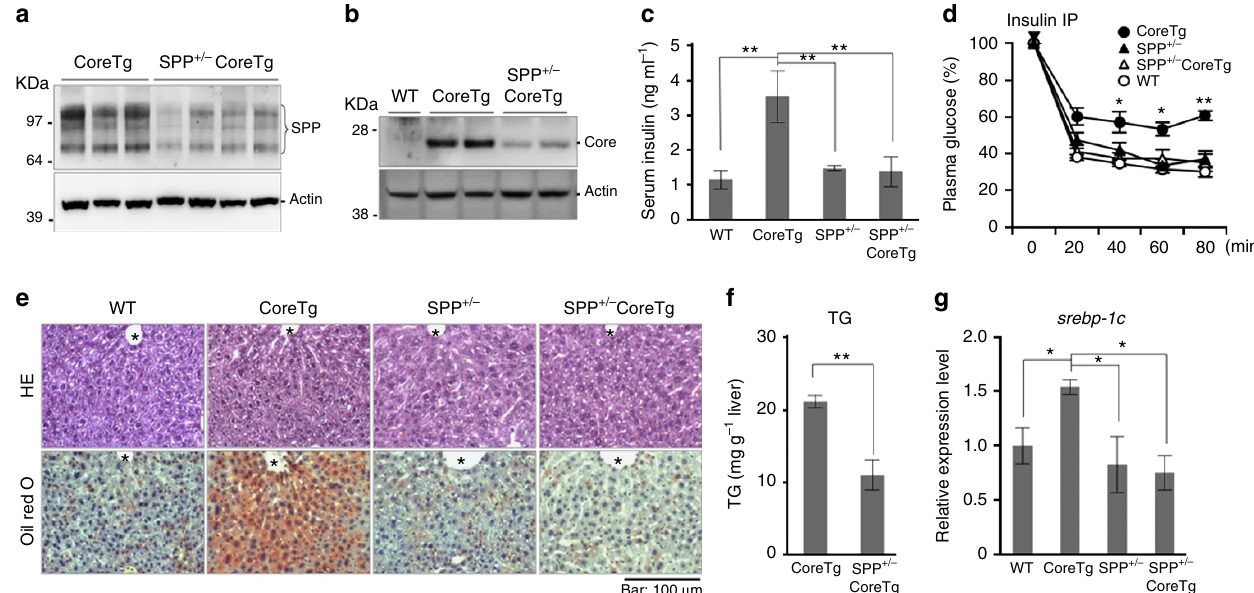
Figure 4 | SPP haploinsufficiency does not cause insulin resistance or steatosis in CoreTg mice. ( a ) Liver lysates from CoreTg male mice ( n ¼ 3) and SPP þ / (cid:2) CoreTg male mice ( n ¼ 4) were subjected to immunoblotting using anti-SPP and anti-Actin antibodies. ( b ) Liver lysates from male mice of the WT, CoreTg and SPP þ / (cid:2) CoreTg groups were subjected to immunoblotting. ( c ) The serum insulin concentrations of four mice of each of the WT, CoreTg, SPP þ / (cid:2) and SPP þ / (cid:2) CoreTg groups (18–19 weeks old) under fed conditions were determined by ELISA. Significant increases are indicated by